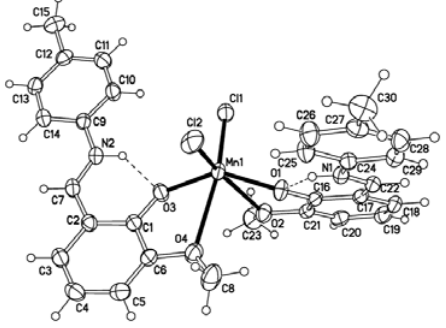
Figure 1. Molecular structure of the complex 1 (probability of ellipsoid is 30%). Intramolecular hydrogen bonds are depicted as dashed